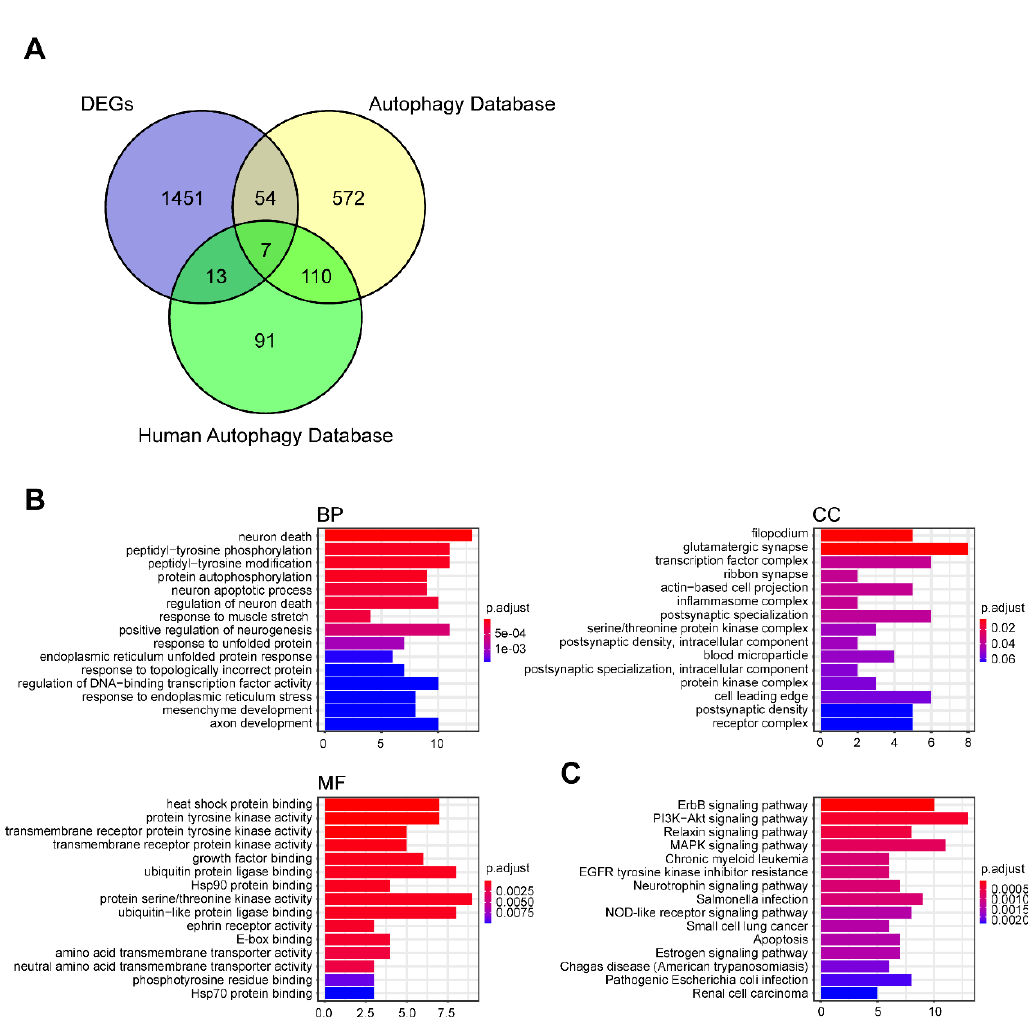
Figure 4. Identification of differentially expressed autophagy-related genes. ( A ) Venn diagram showing the overlap of genes between TAAD DEGs and autophagy associated genes. ( B ) GO enrichment analysis of overlap genes. ( C ) KEGG pathway enrichment analysis of overlap genes.